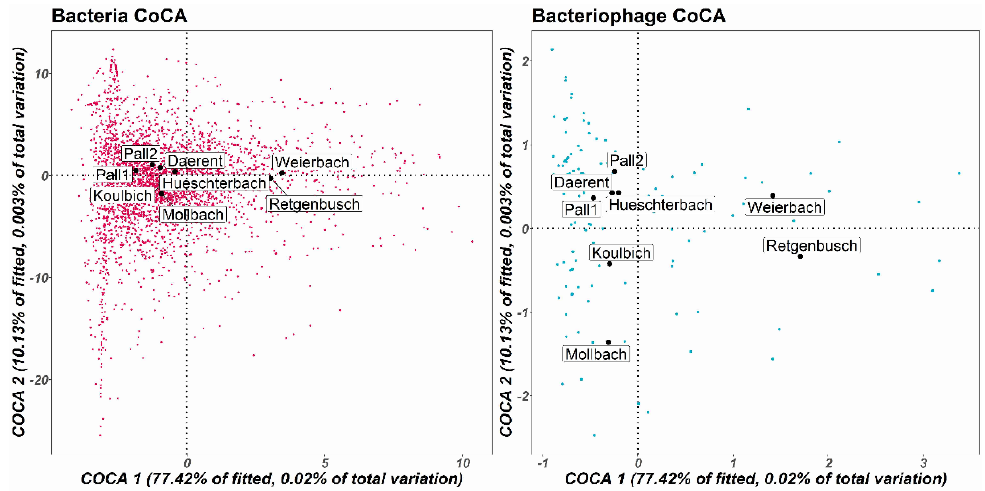
Figure 7. Symmetric co-correspondence analysis (Sym-CoCA) of both total bacteria and DNA bacteriophage community compositions. The bacterial genera are represented in pink and bacteriophage genera, in blue. Here, they were built over the two first dimensions, where 77.42% of the fitted covariation between the two matrices was explained by COCA1 and 10.13% by COCA2. The sites are displayed in black.